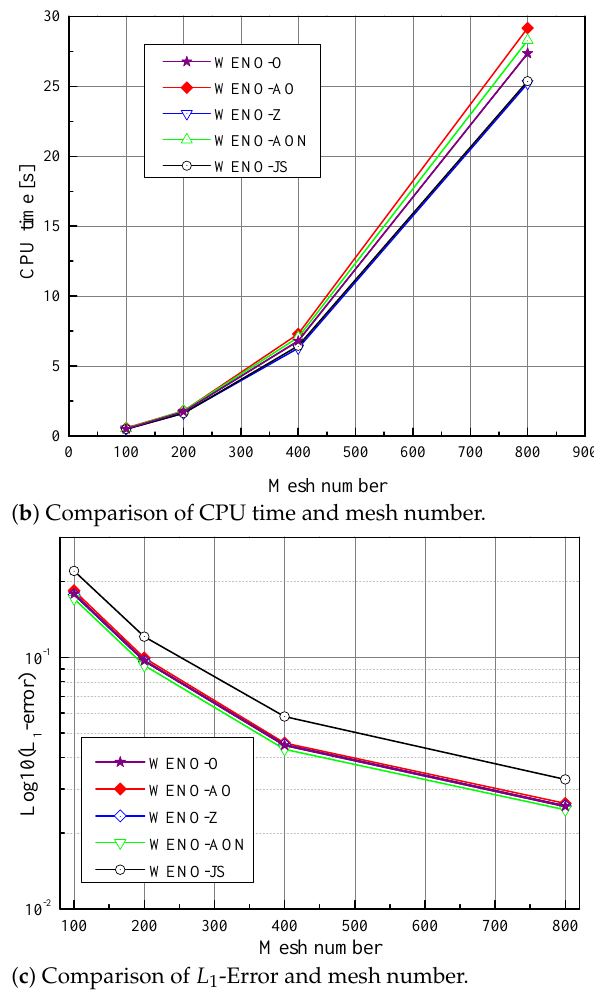
Figure 11. The accuracy comparison of the considered WENO schemes for Lax’s problem of Example 4 (Section 6.2.1) for density field at time t = 1.3, CFL = 0.95.